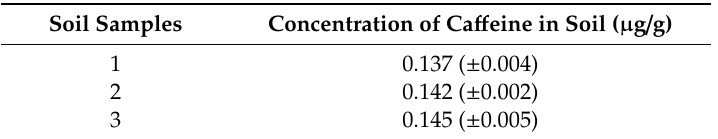
Table 4. The concentration of caffeine from the soil collected from three different locations at Vinatea-green tea farm.